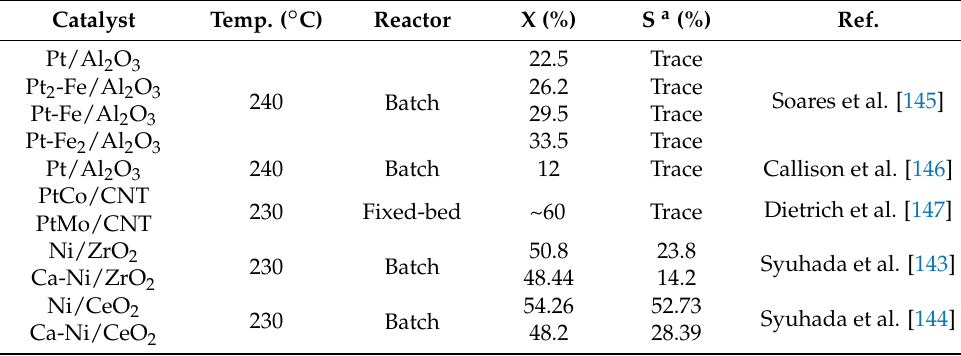
Table 5. Heterogeneous catalyst used for glycerol APR to